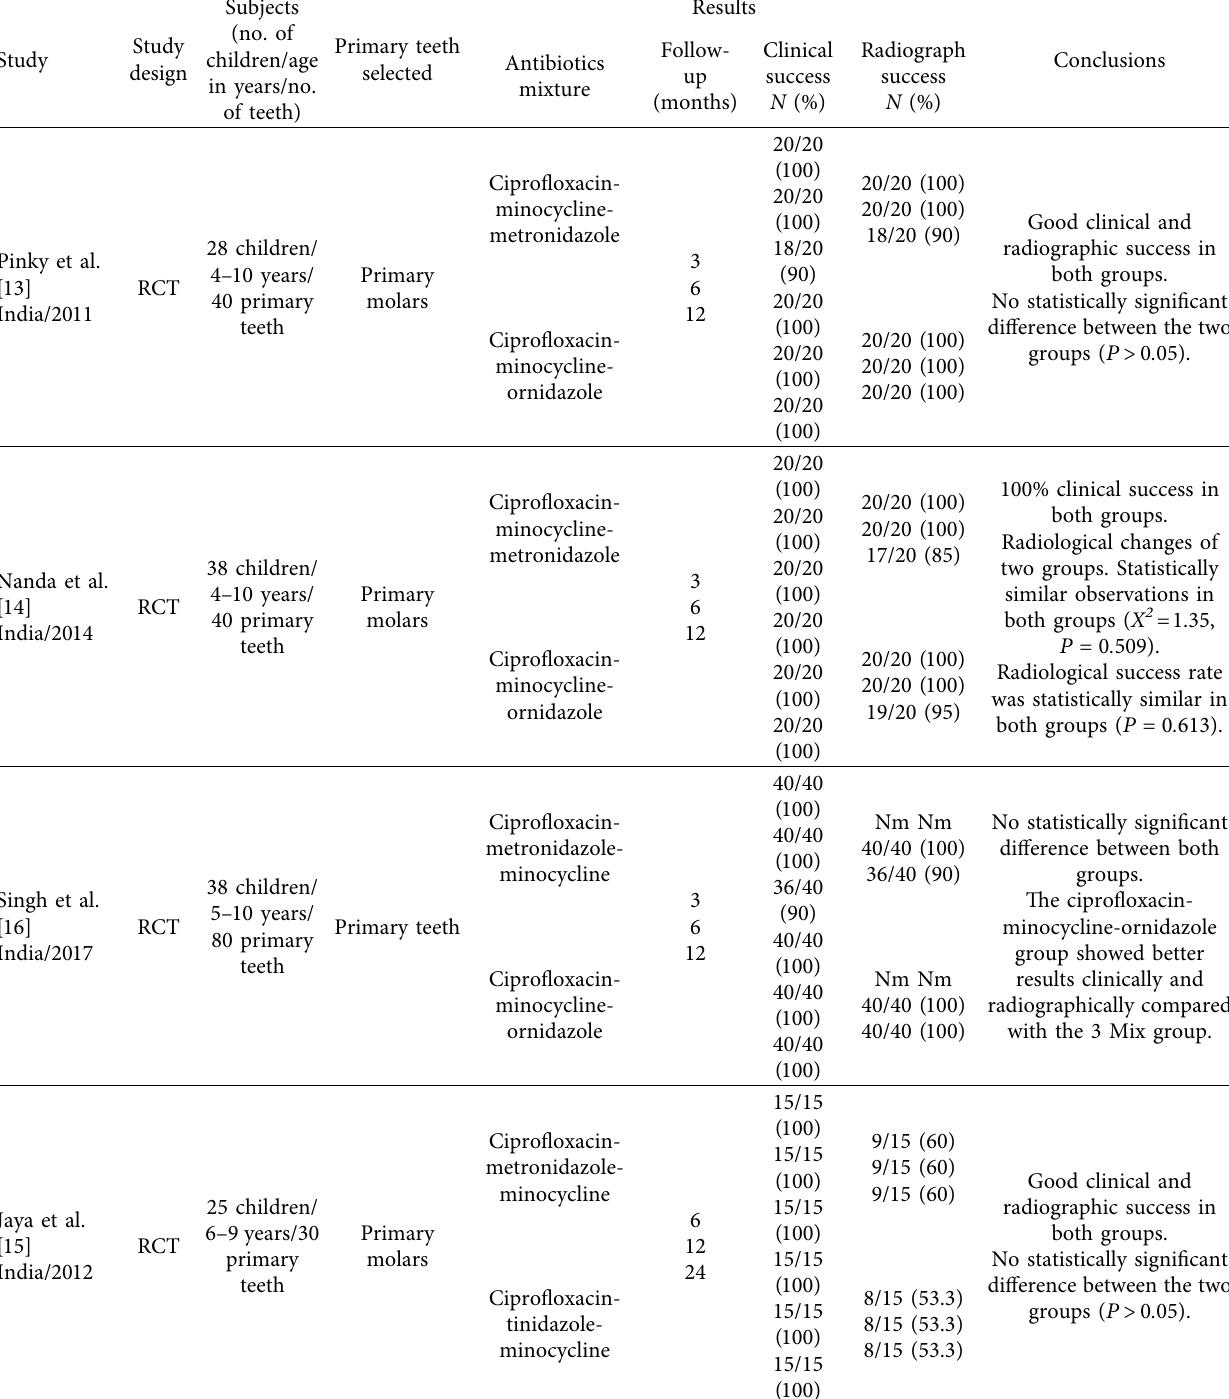
Table 2: Characteristics of the included